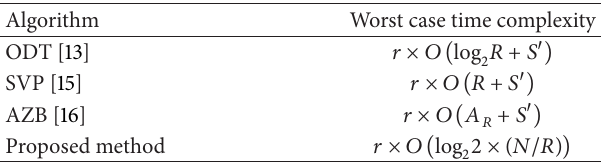
Figure 12: Ray prediction in a sample hospital environment. Table 1: Time complexity of the proposed and existing ray tracing algorithms.